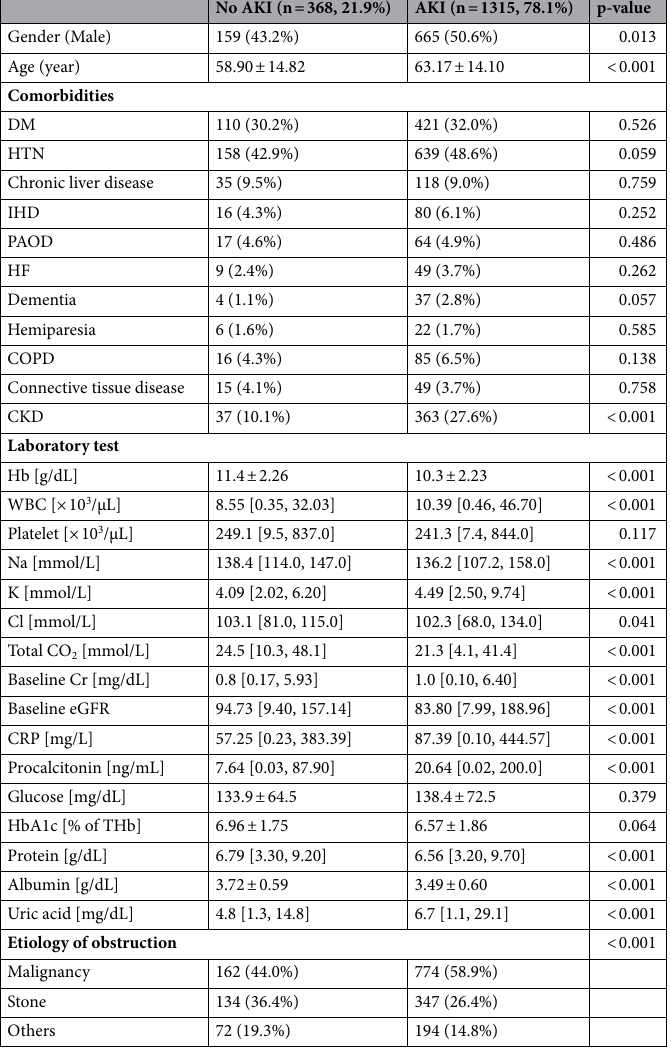
Table 2. Demographic and clinical characteristics of the study cohort according to the presence of AKI. DM diabetes mellitus, HTN hypertension, IHD ischemic heart disease, PAOD peripheral arterial occlusive disease, COPD chronic obstructive pulmonary disease, CKD chronic kidney disease, Hb hemoglobin, eGFR estimated glomerular filtration rate, CRP C-reactive protein, AKI acute kidney